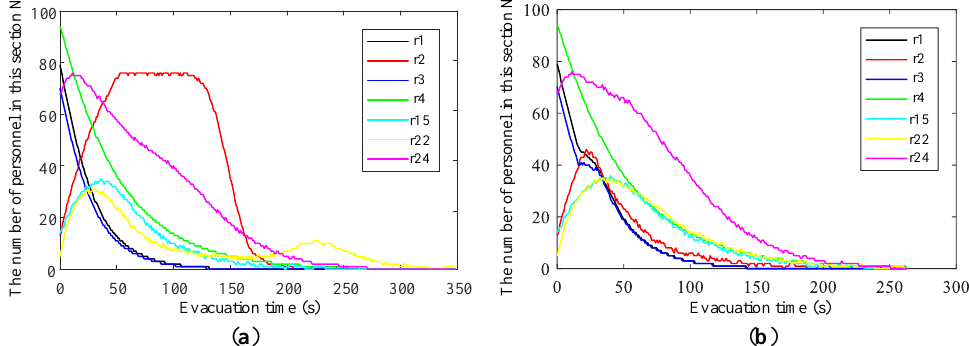
Figure 15. ( a ) The variation of the number of people in each roadway section under the shortest evacuation route strategy; ( b ) the variation of the number of people in each roadway section under the shortest evacuation time route